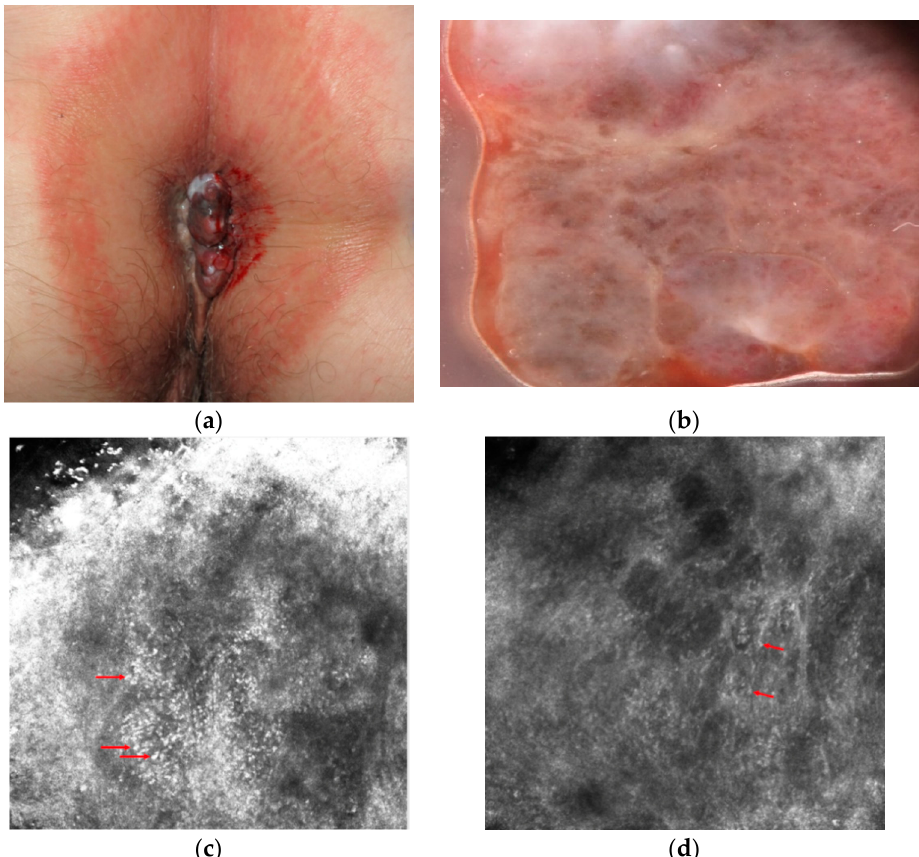
Figure 1. Clinical ( a ), dermoscopic ( b ) and RCM ( c , d ) aspect of a hypomelanotic mucosal melanoma. ( b ) Dermoscopy shows structureless grey and white color and remnants of pigmentation. ( c , d ) Reflectance confocal microscopy features at the epidermal level (images acquired with VivaScope 3000, Caliber, New York, USA): atypical cells are indicated by red arrows.